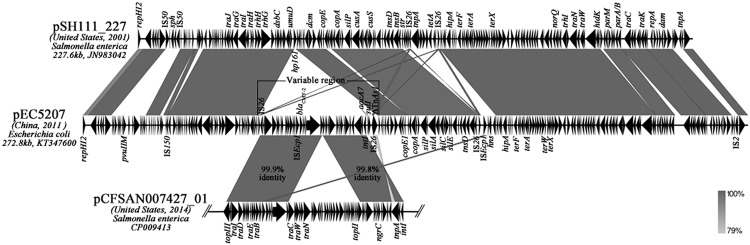
Linear comparison of IncHI2 plasmids pEC5207, pSH111_227 and blaCMY-2-carrying IncA/C plasmid pCFSAN007427_01. The arrows represent the positions and transcriptional direction of the ORFs. Regions of homology are shaded in gray.